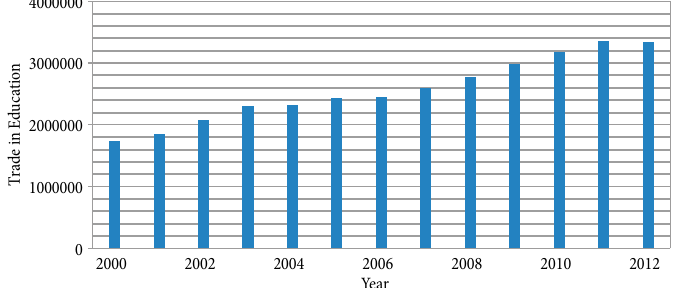
Fig. 3. Trade in education, 2000 to 2012 (number of internationally mobile students) Source : OECD